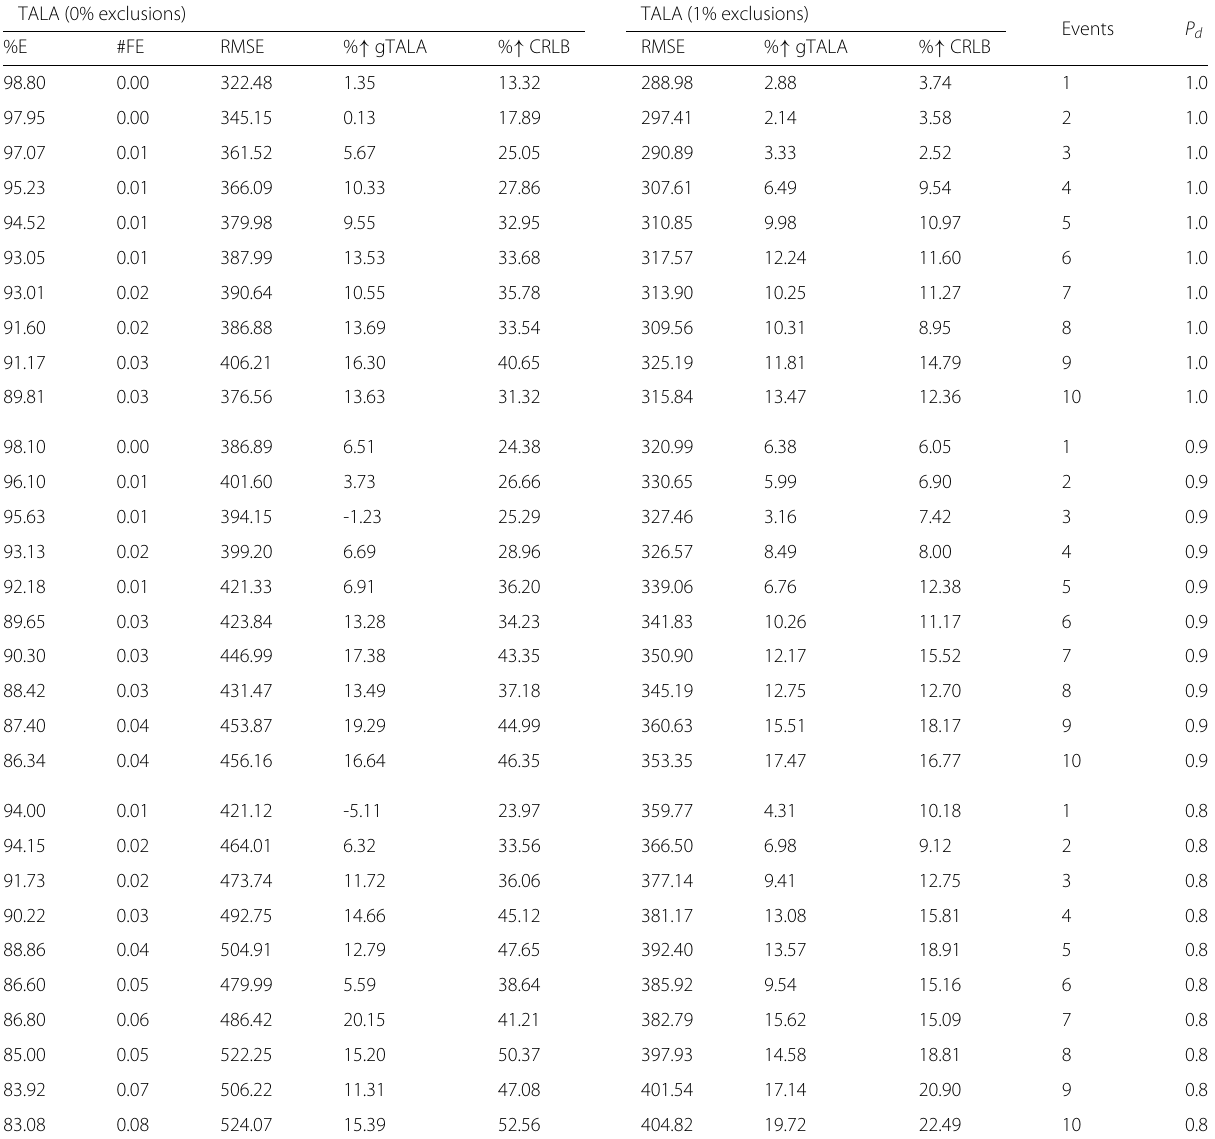
Table 7 Summary of the TALA geo-location performance for scenario